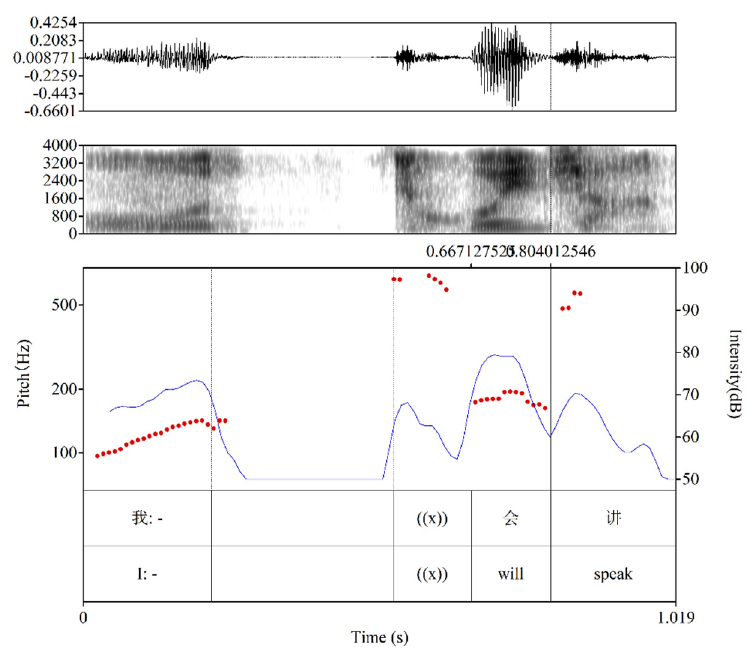
Figure 10. Waveform, spectrogram, pitch contour, and intensity of line 08 in Ex 21 . The [ w ǒ huì X ( de )] format with stressed huì in general is used to reassure the recipient of an existing commitment. It is observed in environments where the speaker has an